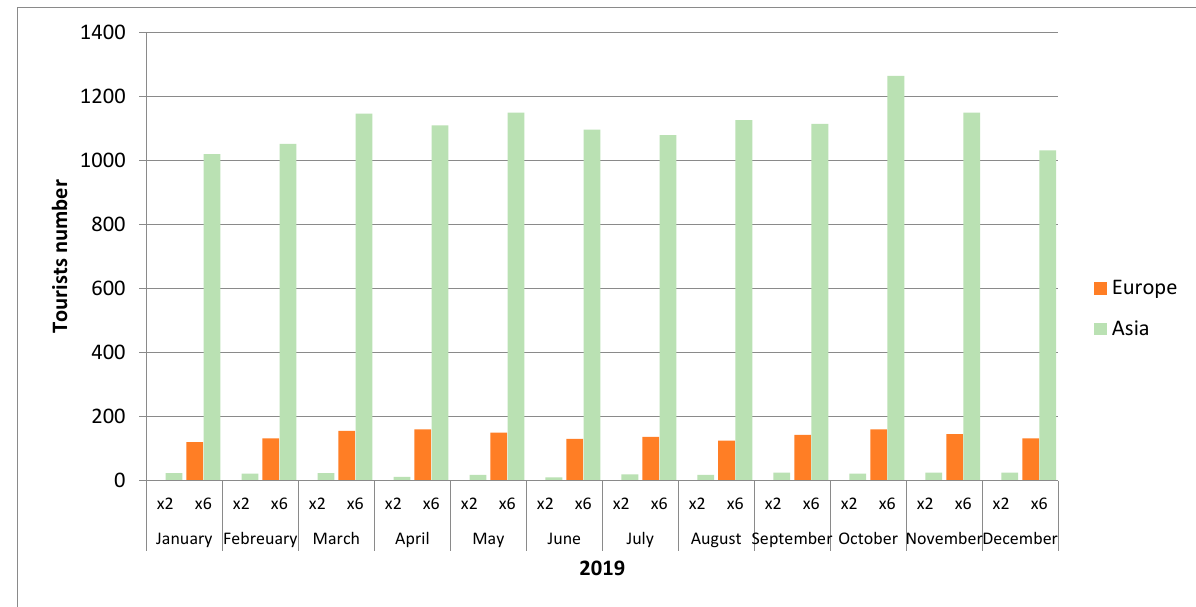
Figure 7. Cluster A content visualization using color coding for January when N = 8 . A cluster content explanation chart was used for all clusters throughout the year to monitor how the nationalities number changed in the same cluster from January to De- cember. For example: Figure 8 shows the cluster B content explanation chart. The y-axis represents the number of tourists for each geographical area in the cluster, and the x-axis represents the offices within cluster B throughout the year.